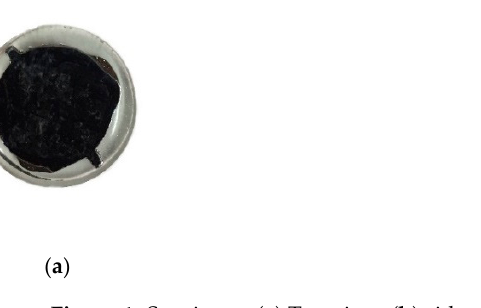
Figure 1. Specimen: ( a ) Top view; ( b ) side view.